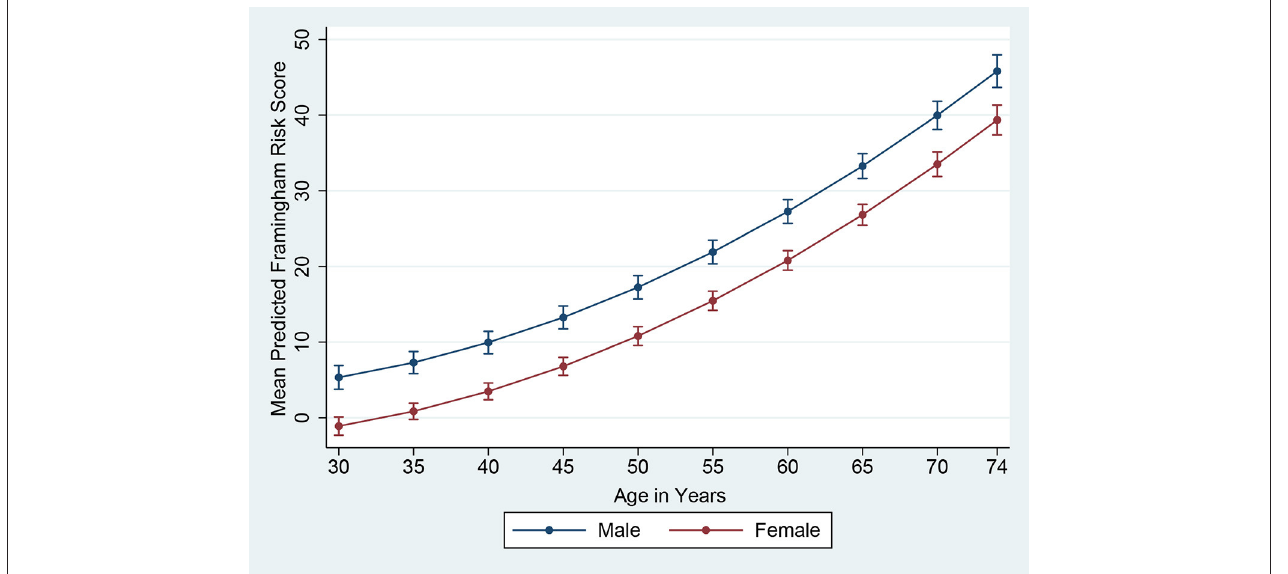
FIGURE 1 | Framingham Risk Score by age and gender (vertical lines are means with 95% CIs).